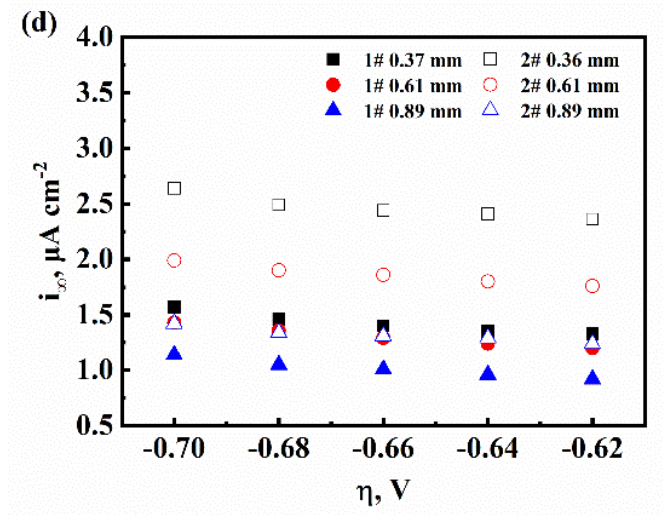
Figure 3. The hydrogen permeation tests of 1# and 2# steel with different thicknesses obtained in 0.05 mol/L H 2 SO 4 at 25 °C: ( a ) The hydrogen permeation curve of 1# steel with different specimen’s thickness; ( b ) The hydrogen permeation curve of 2# steel with different specimen’s thickness; ( c ) The relation between i c and η; ( d ) The relation between i ∞ and η .